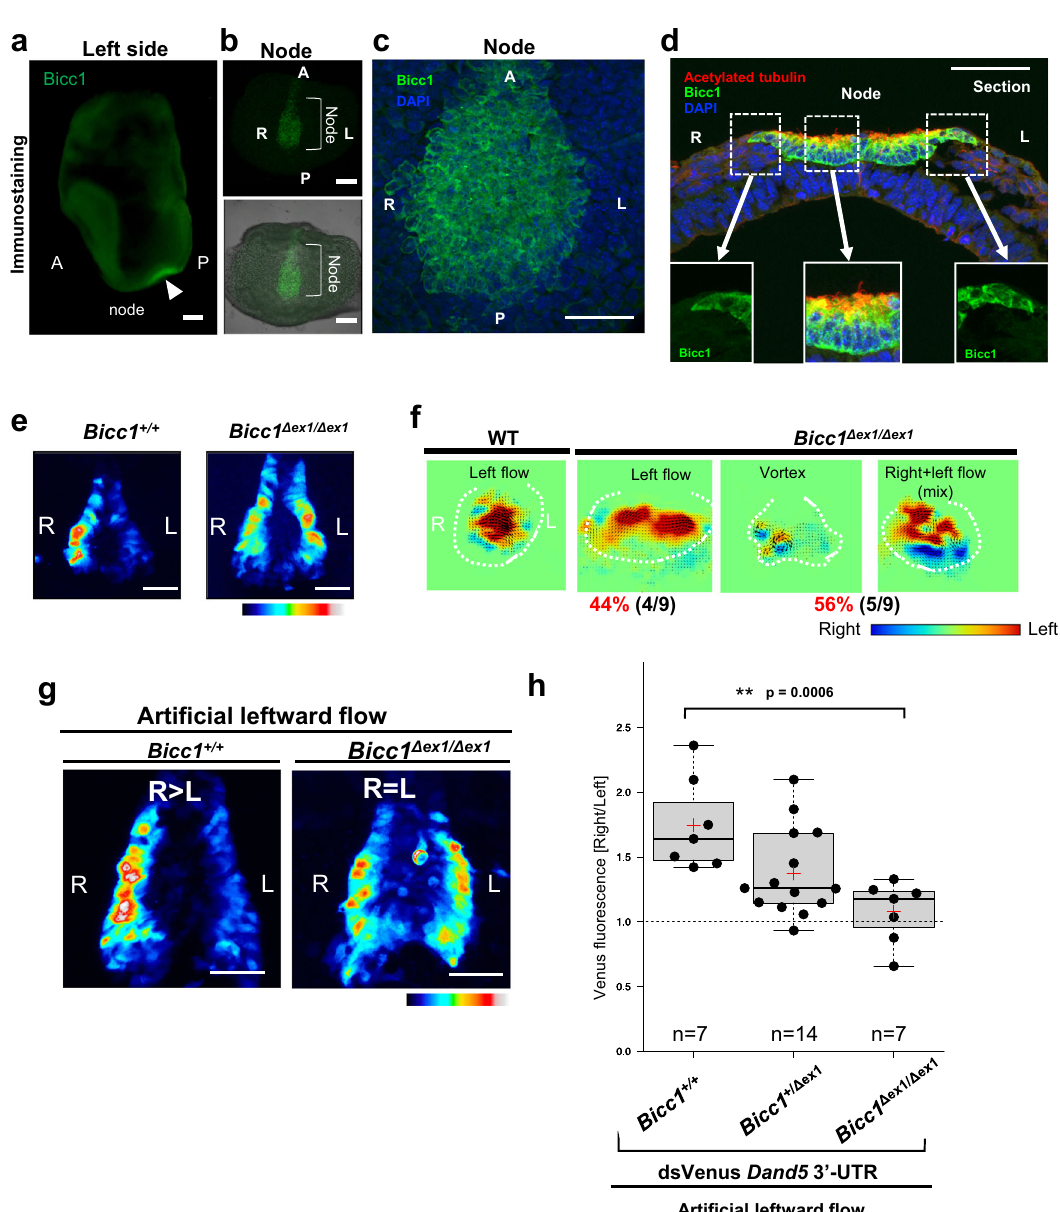
Fig. 4 Flow-induced decay of Dand5 mRNA depends on Bicc1. a - d Immuno fl uorescence staining of Bicc1 in node cells of a WT embryo at E8.0 ( a ), or its node region at higher magni fi cation ( b , c ), and in a transverse section of the node ( d ). Nuclei were stained with 4 ’ ,6-diamidino-2-phenylindole (DAPI) in ( c ) and ( d ), and acetylated tubulin was also immunostained in ( d ) to reveal cilia. Scale bars in ( a , b ) and ( c , d ) are 100 µ m and 50 µ m, respectively. Images shown in ( a - d ) are representative of at least two independent experiments. e dsVenus fl uorescence at the node of four- to six-somite stage WT and Bicc1 Δ ex1/ Δ ex1 embryos harboring the NDE-Hsp-dsVenus-3 ′ -UTR transgene. Scale bars, 50 µ m. Images shown are representative of six embryos for each genotype. f Nodal fl ow in WT and Bicc1 Δ ex1/ Δ ex1 mouse embryos at three- to fi ve-somite stages as revealed by particle image velocimetry (PIV) analysis. The dashed white line indicates the outline of the node, small arrows in the node region indicate the direction and velocity of fl ow at those positions. The relative color scale indicates the magnitude of fl ow velocity (leftward in red, rightward in blue). Note that leftward laminar fl ow was lost in fi ve out of nine Bicc1 Δ ex1/ Δ ex1 embryos, whereas the four others showed normal leftward fl ow. g Bicc1 + / + and Bicc1 Δ ex1/ Δ ex1 embryos harboring the NDE-Hsp-dsVenus- 3 ′ - UTR transgene were cultured in the presence of an arti fi cial leftward fl ow as in Fig. 2c, after which the L-R pattern of dsVenus fl uorescence at the node was examined. Scale bars, 50 µ m. h Quanti fi cation of Right/Left ratios of dsVenus fl uorescence at the node of NDE-Hsp-dsVenus-3 ′ -UTR embryos of the indicated genotypes after culture in leftward arti fi cial fl ow as in ( g ). The n values indicate the numbers of embryos analyzed, and red crosses indicate average values. For the boxplots, the top and bottom lines of each box represent the 75th and 25th percentiles of the samples, respectively. The line inside each box represents the median of the samples. The upper and lower lines above and below the boxes are the whiskers. Statistical signi fi cance (p) was determined using the two-sided Wilcoxon rank sum test. Source data are provided as a Source Data fi le. Note that the arti fi cial leftward fl uid fl ow failed to rescue the impaired L-R pattern of dsVenus fl uorescence in the Bicc1 Δ ex1/ Δ ex1